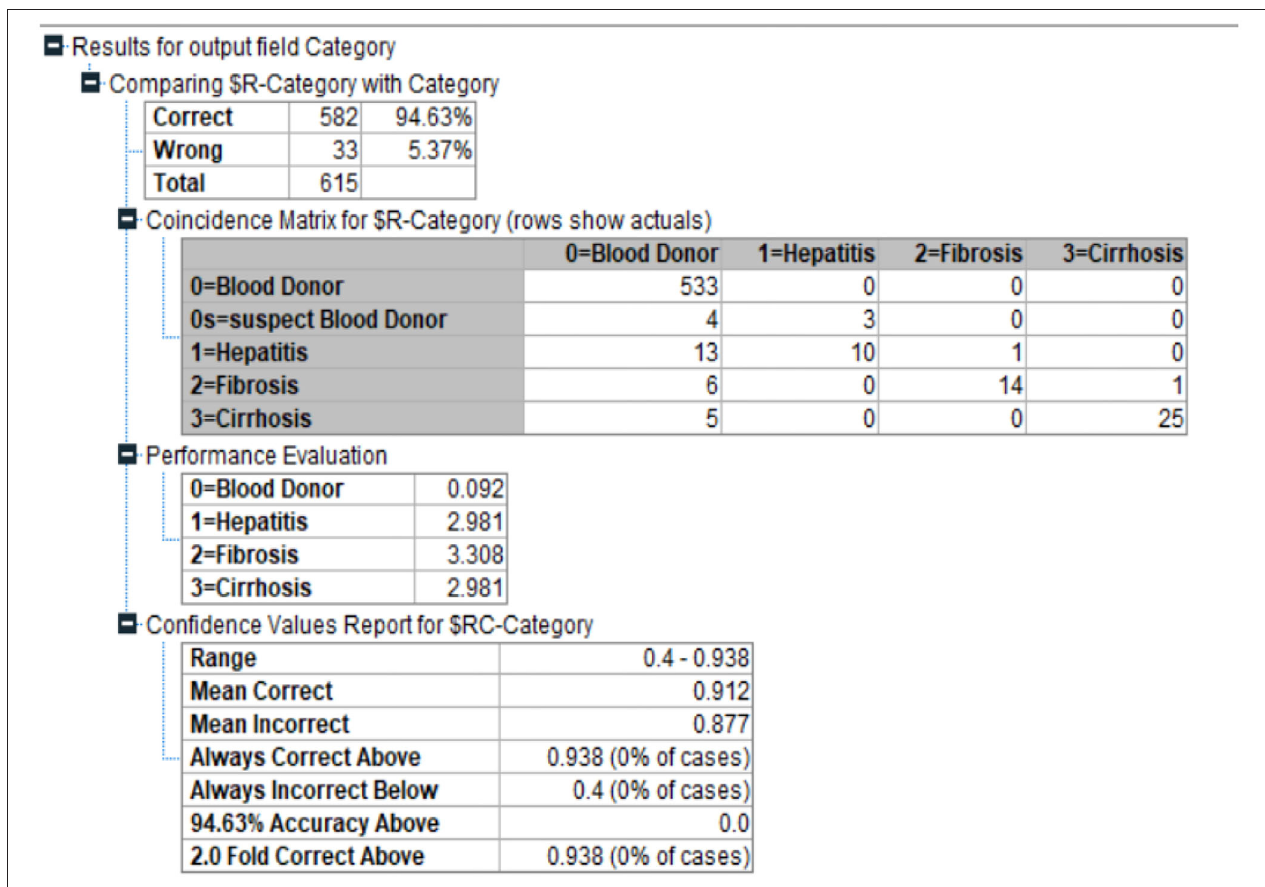
FIGURE 8 | Quest Classification for